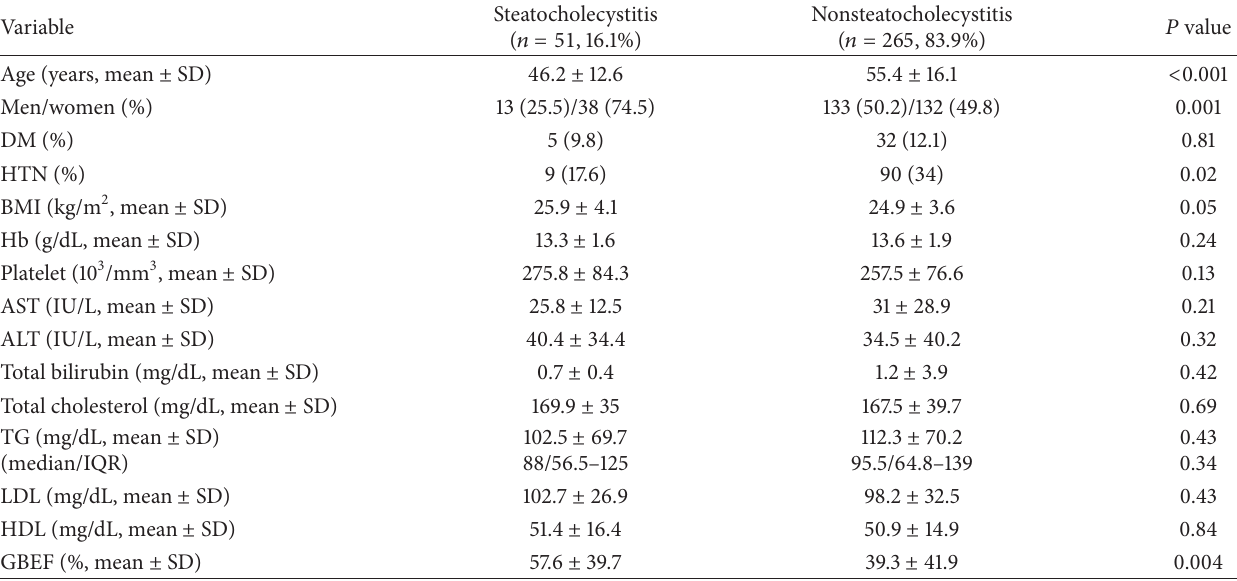
Table 5: Univariable analysis for clinical risk factors of steatocholecystitis in patients with calculous cholecystitis. Variable